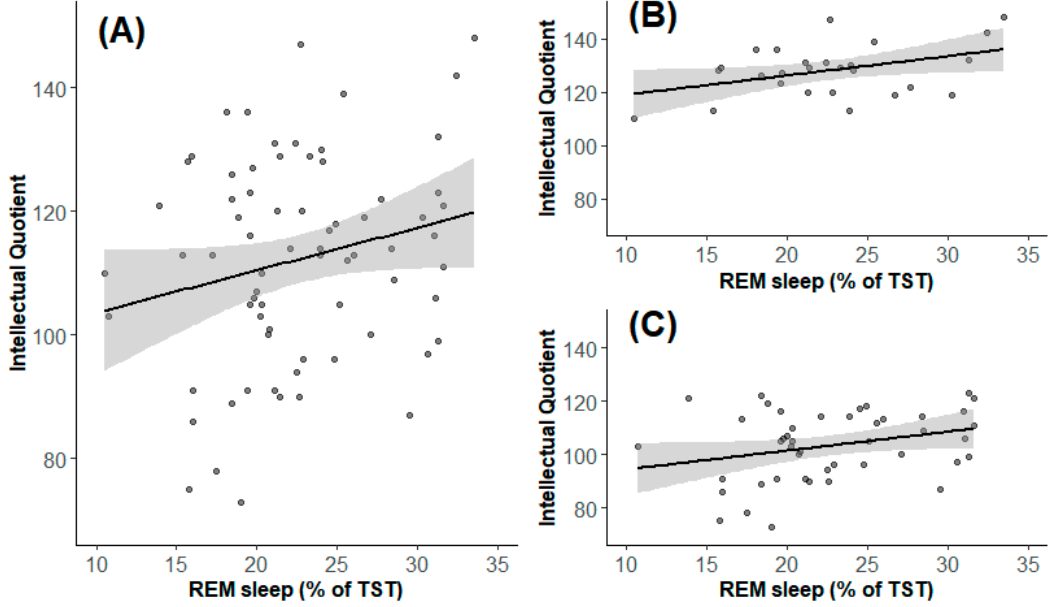
Figure 2. Correlation between IQ and the percentage of REM in the entire group of children with narcolepsy ( A ), in children with HP ( B ) and in children without HP ( C ). Each point represents the percentage of REM sleep for each subject according to the IQ. IQ: Intellectual quotient; REM sleep: Rapid eye movement sleep; HP: High potential.